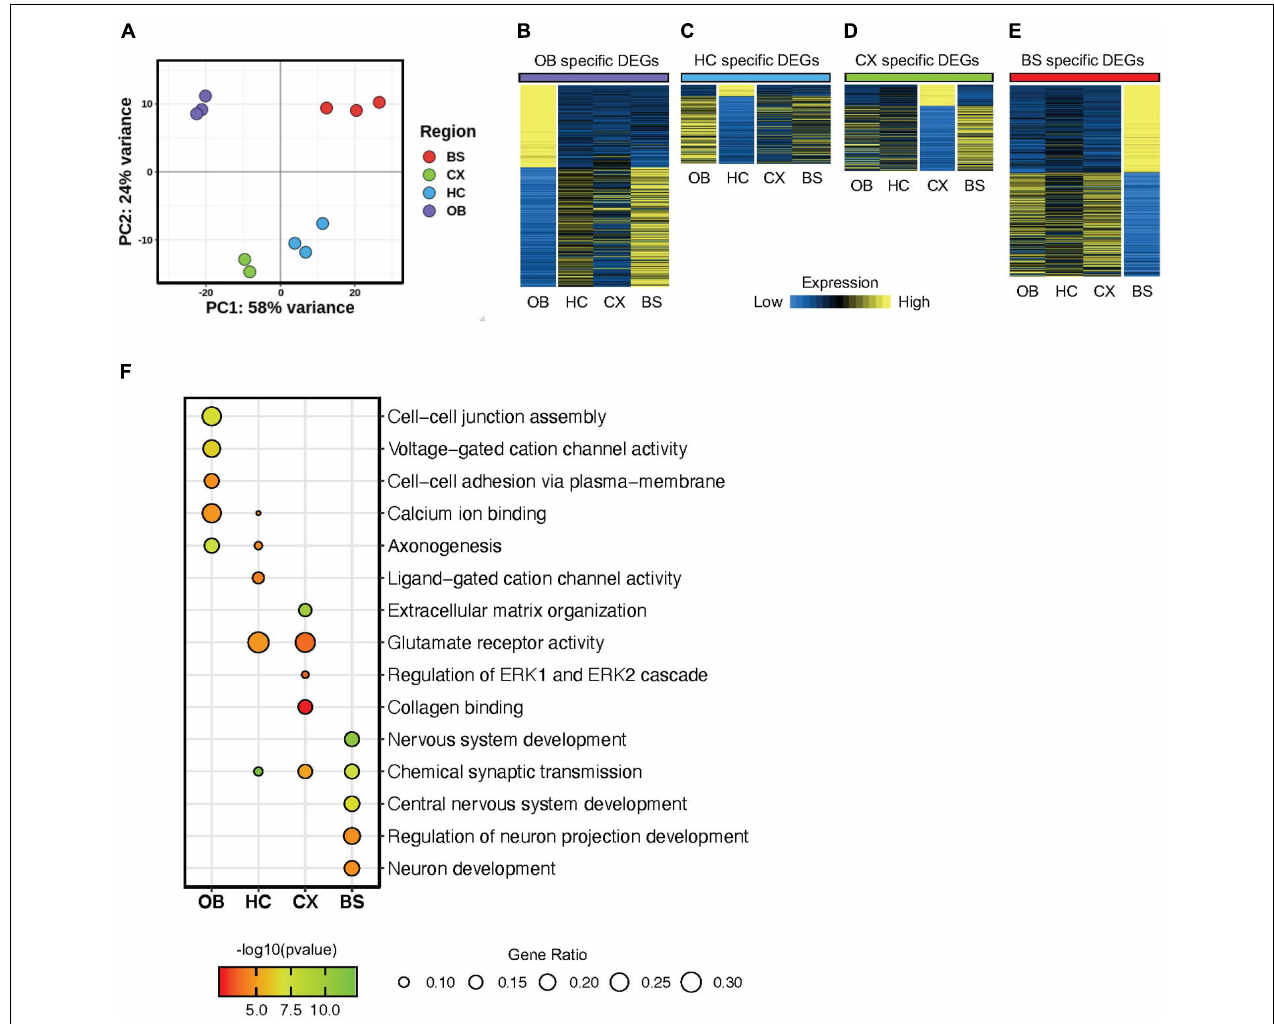
FIGURE 2 | Astrocytes display regionally distinct gene signatures. (A) Principal component analysis plot from RNA-Seq results of four brain regions. (B–E) Heatmap showing differentially expressed genes from each region (B) OB DEGs; purple, (C) HC DEGs; blue, (D) CX DEGs; green, (E) BS DEGs; red p -value < 0.01 for all regions. (F) Gene Ontology analysis plot of regional differentially expressed